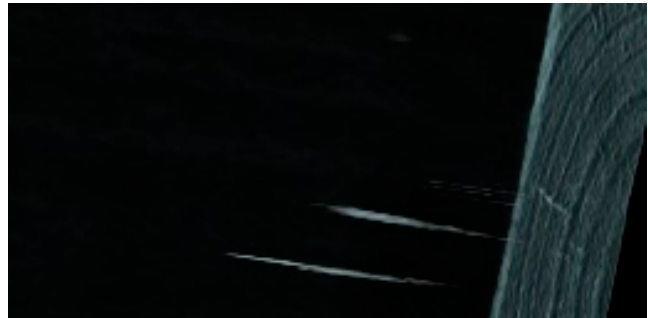
Figure 9. Demonstration of identification of internal cracks in the tested sample and their exact po- sition (range) by volume rendering technique.